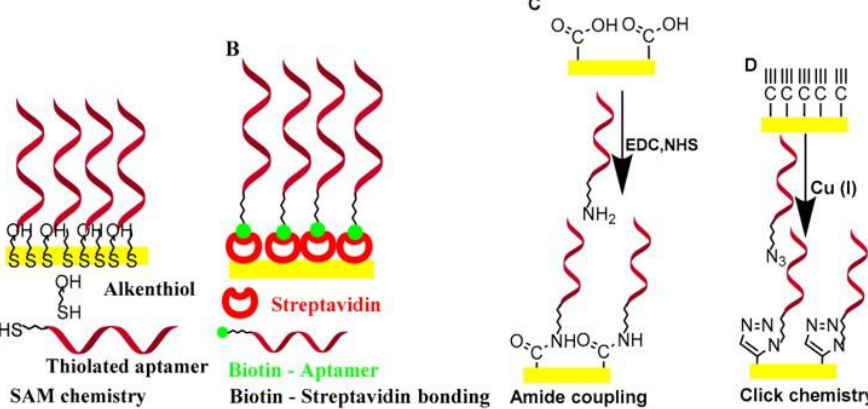
Figure 7. The common surface immobilization methods for aptamers. ( A ) SAM (self-assembled monolayer) chemistry, ( B ) biotin–streptavidin bonding, ( C ) amid coupling, and ( D ) click chemistry. Reprinted with permission from Ref. [46]. copyright © 2022, MDPI